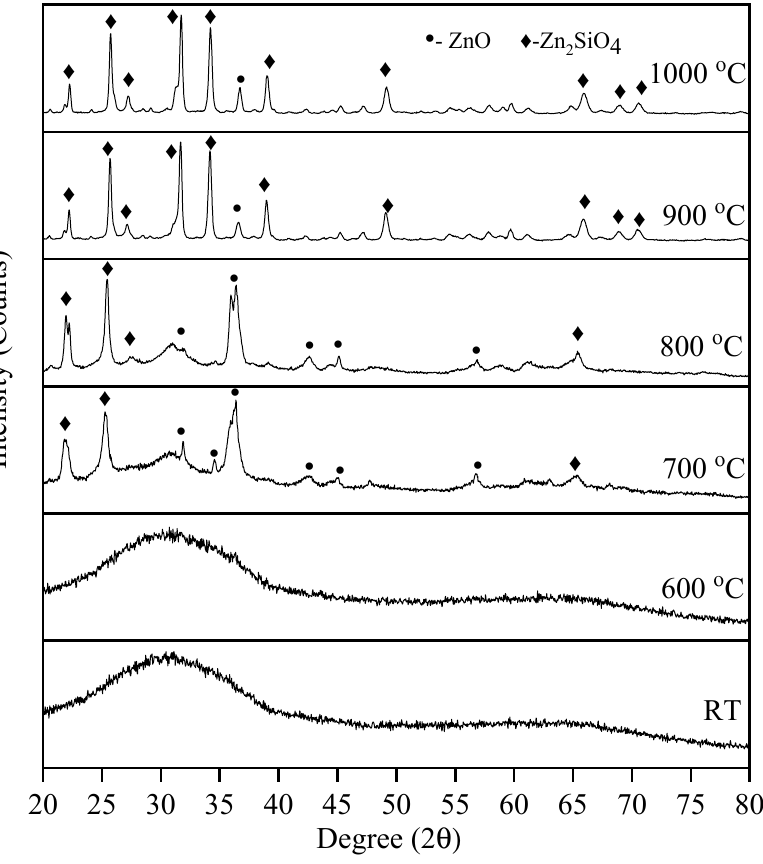
Figure 5. XRD patterns of Zn 2 SiO 4 sintered at different temperatures.